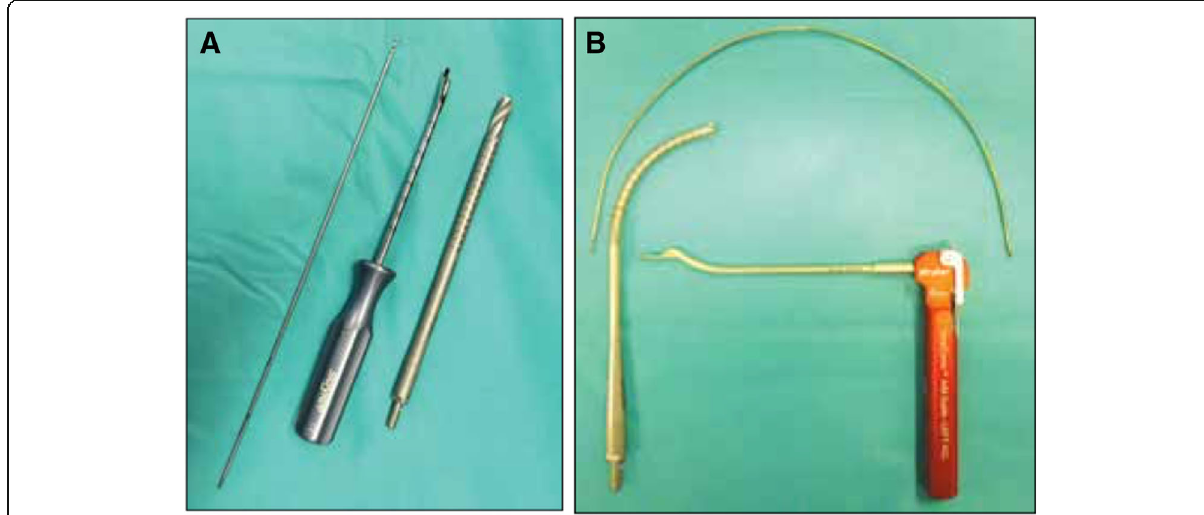
Fig. 1 Images of the Versi-Tomic® system with rigid ( a ) and flexible ( b ) reamers